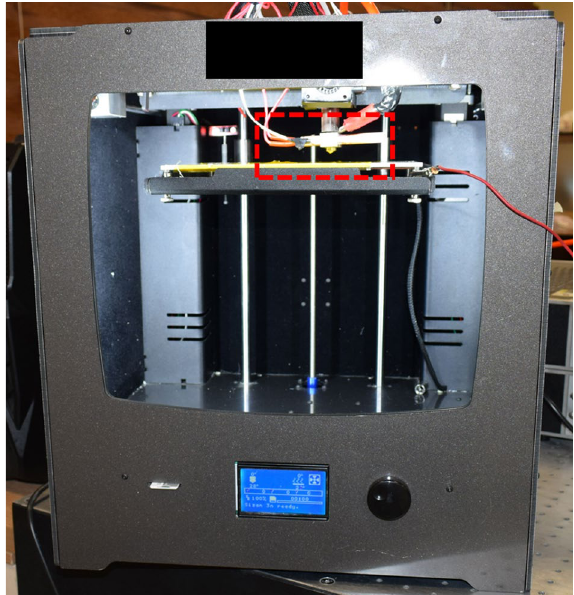
Figure 2. FDM 3D printer used in this study as the MEW